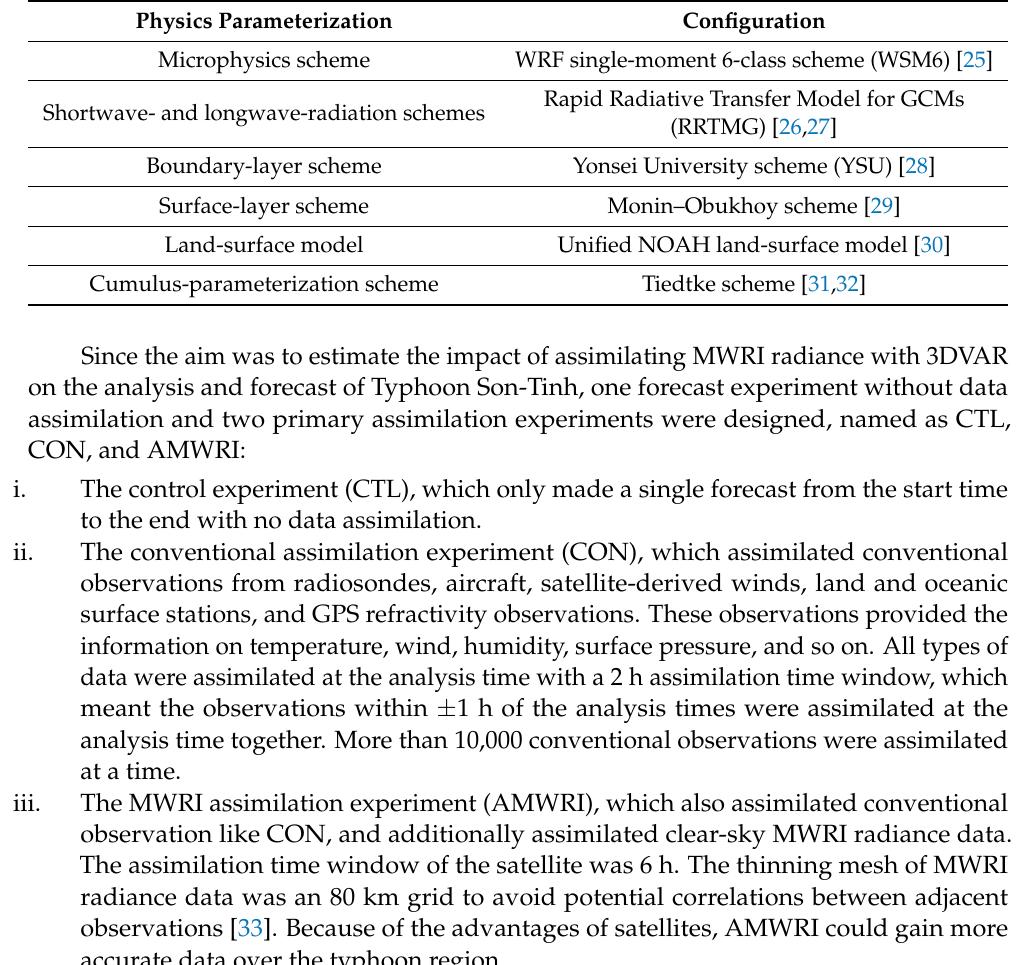
( a ) ( b ) Figure 3. The ( a ) best track and ( b ) minimum sea level pressure (MSLP) of Typhoon Son-Tinh. Table 2. The configuration of the physics